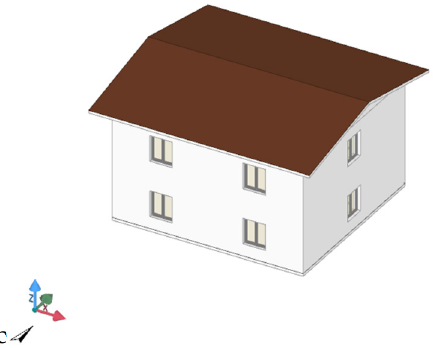
Figure 2. Single-family building (MF).